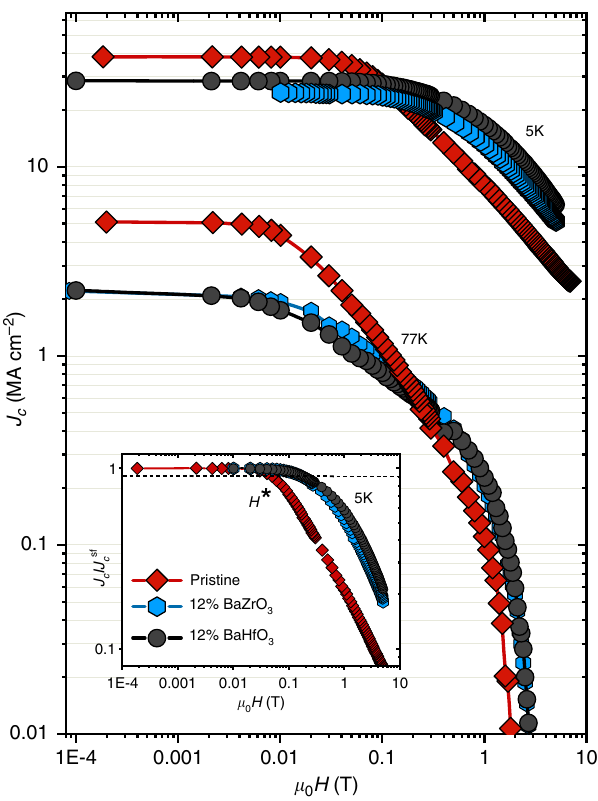
Fig. 3 Inductive critical current density, J c , as a function of the magnetic fi eld for TLAG fi lms. A pristine YBCO fi lm and two nanocomposites of 12% molar BZO and 12% molar BHO of composition 3:7 are shown for 5 K and 77 K. The growth conditions followed the P O2 -route at temperature of 835 °C and P O2, fi nal = 10 − 3 bar. Samples are 90 nm thick. The inset shows the normalized J c for the self- fi eld value at 5 K for the same three fi lms. The H* parameter is de fi ned with the criterion of the value of H at 0.9 times J fi eld. The irreversibility line obtained from electrical transport c at self- measurements is shown in Supplementary Figure 6, displaying an µ 0 H irr (77 K) ~ 8.1 T.